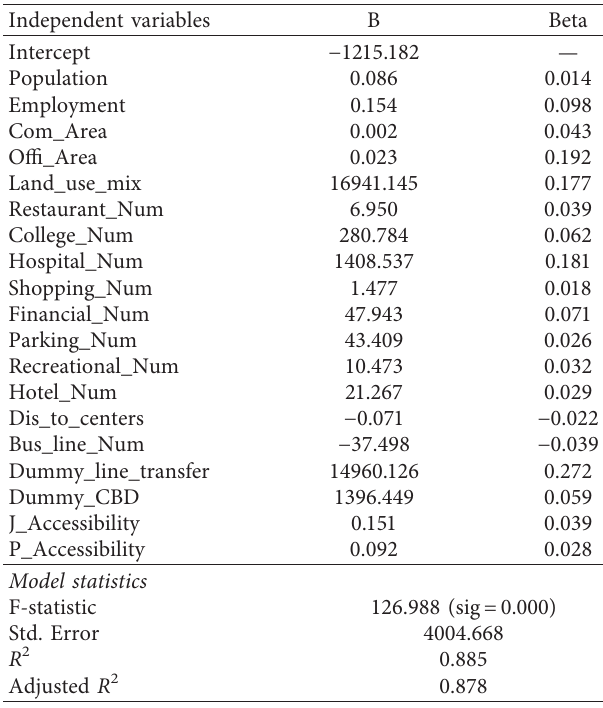
Table 7: Direct ridership model (DRM) estimating daily ridership at the station level in Wuhan,